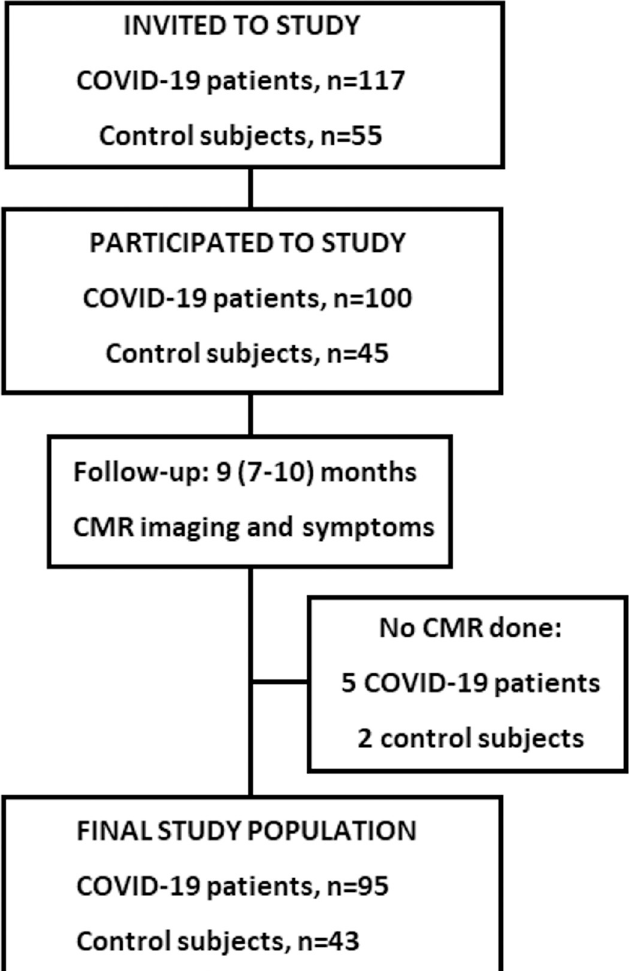
Fig 1. A flowchart on the patient enrollment to the study. CMR = cardiac magnetic resonance; COVID- 19 = coronavirus disease 2019.